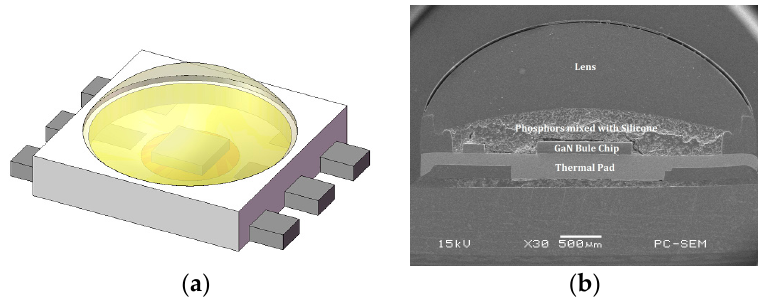
Figure 1. ( a ) The 3D model of selected light-emitting diodes (LED) package; ( b ) its packaging materials and construction shown in the scanning electron microscope image of cross-section.